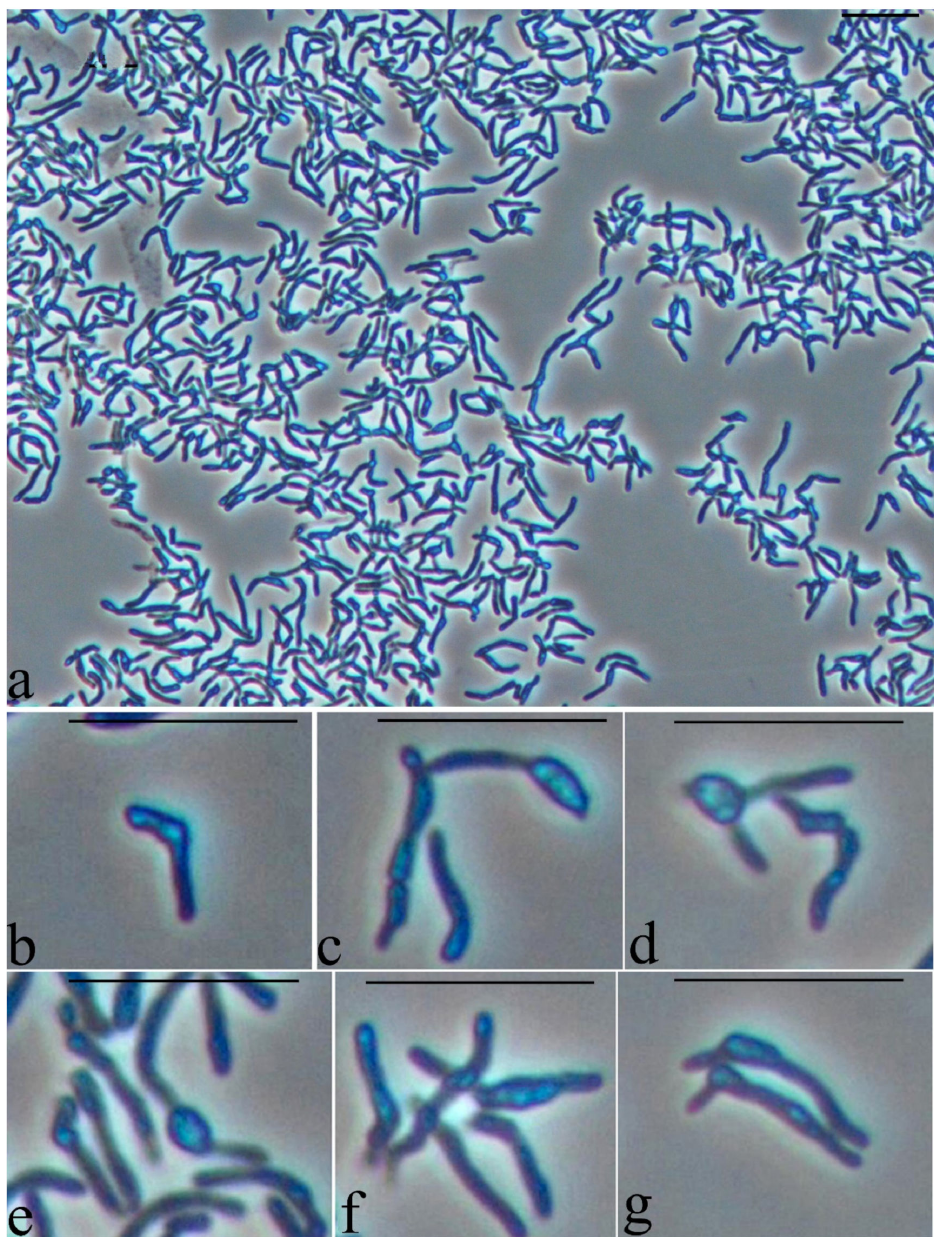
Figure 5. Strain S8 on glucose 1 day of growth. Light microscopy, phase contrast. The length of the scale bar is 10 µ m. The cells have the shape of long sticks of uneven thickness, often branching ( a , d , g ), with characteristic large refractory inclusions ( b – g ), the size of which often exceeds the thickness of the cells ( c , d , e , g